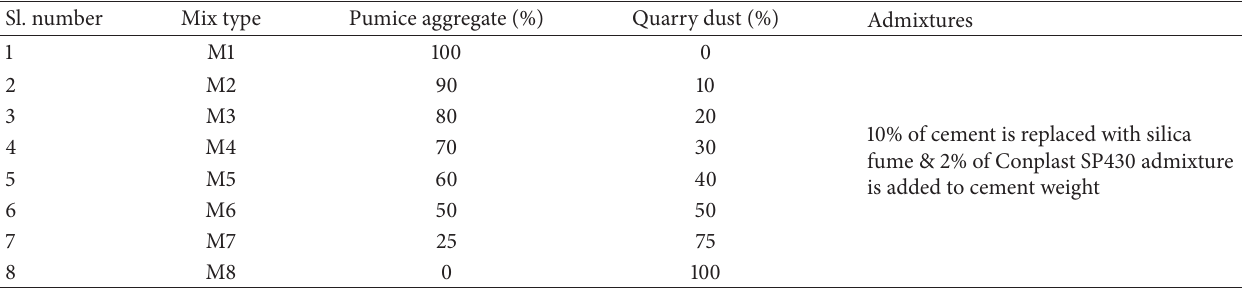
Table 2: Mixing proportions.